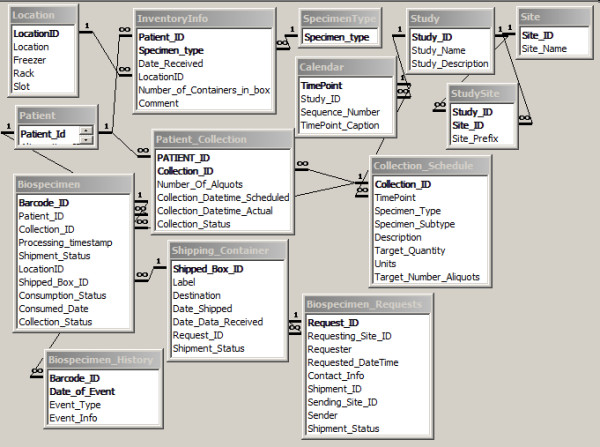
Database schema.